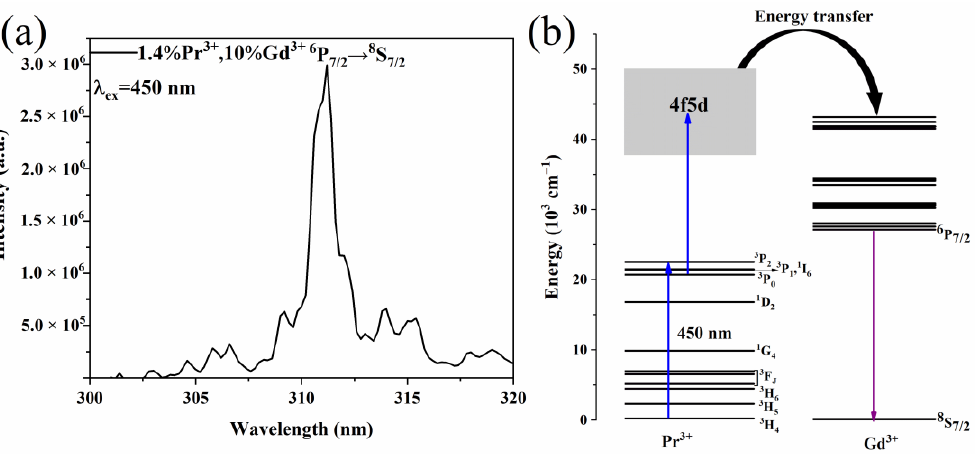
Figure 8. ( a ) UC Emission spectra (λ ex = 450 nm) of the Y 7 O 6 F 9 :1.4%Pr 3+ , 10%Gd 3+ . The output power was 0.38 W. ( b ) UC energy transfer mechanism of Pr 3+ to Gd 3+